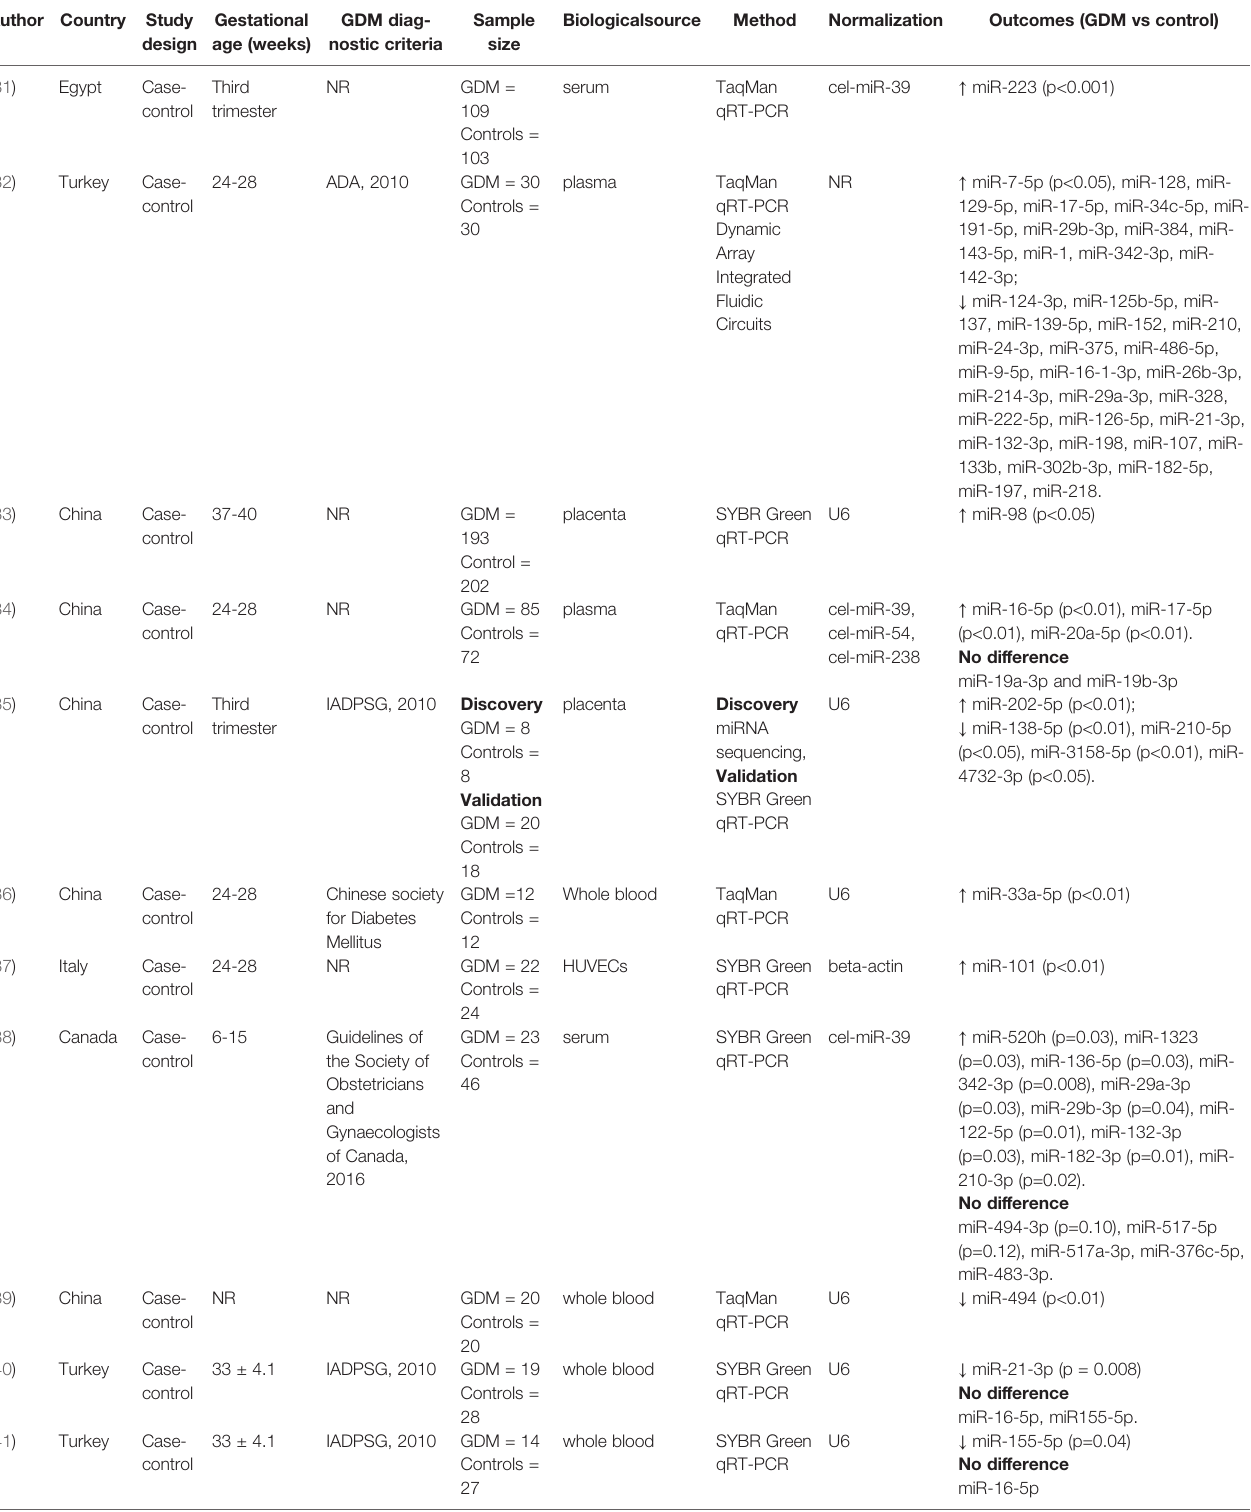
TABLE 1 | Studies pro fi ling microRNAs in pregnancies complicated by maternal diabetes. Author Country Study Gestational design age